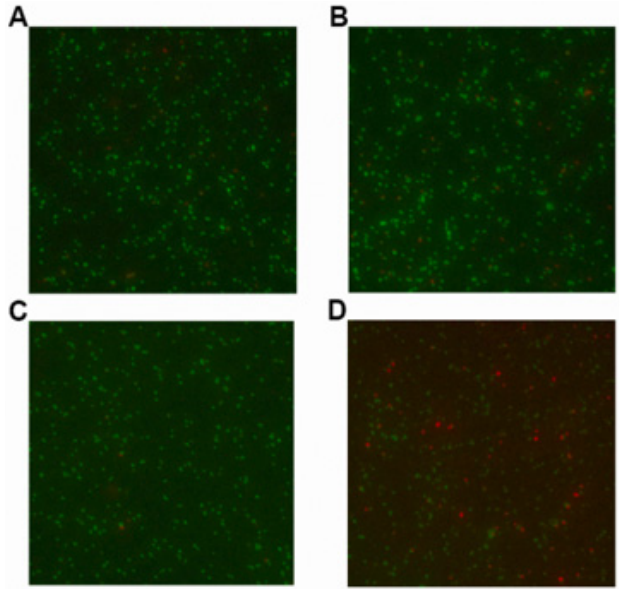
Figure 8. Synergistic bactericidal effects of LCA combined with Genta against L. monocytogenes . The live/dead bacteria with the following treatment were stained with a BacLight LIVE/DEAD staining kit. ( A ) The untreated control. ( B ) L. monocytogenes treated with 8 μ g/mL LCA at 37 °C for 3 h. ( C ) L. monocytogenes treated with 0.125 μ g/mL Genta at 37 °C for 3 h. ( D ) L. monocytogenes treated with 8 μ g/mL LCA and 0.125 μ g/mL Genta at 37 °C for 3 h.